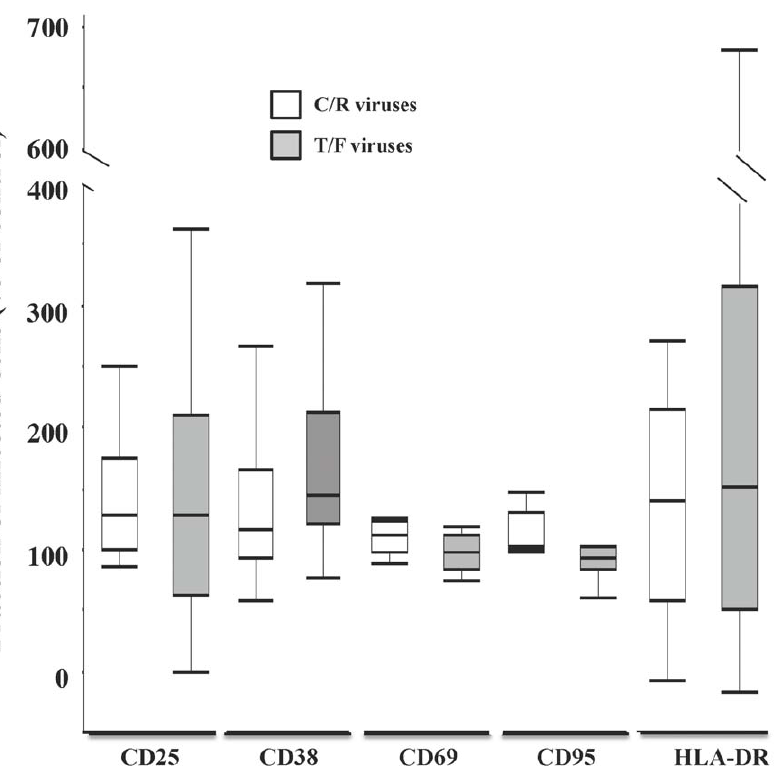
Figure 3. CD4 T cell activation in C/R and T/F HIV-1 variants infected human cervical tissue exvivo . Blocks of human cervical tissue were infected with C/R and T/F viruses and cultured ex vivo . 12 days post infection, the tissues were enzymatically digested and their cells were analyzed by polychromatic flow cytometry. Cells were stained for T cell markers CD3, CD4 and CD8 as well as for the activation markers CD25, CD38, CD69, CD95, and HLA-DR. Infected cells were identified with intracellular staining for HIV-1 p24. The fraction of infected (p24 + ) CD4 T cells expressing a given activation marker was expressed as % of the fraction of T cells expressing the same marker in matched uninfected control tissue. Data showing individual experiments and summary box plots for n=9 to 17 (median, 25 th and 75 th percentiles, and range) of activation marker expression in tissues infected with C/R viruses (empty boxes) and in tissues infected with T/F viruses (filled boxes) are presented.